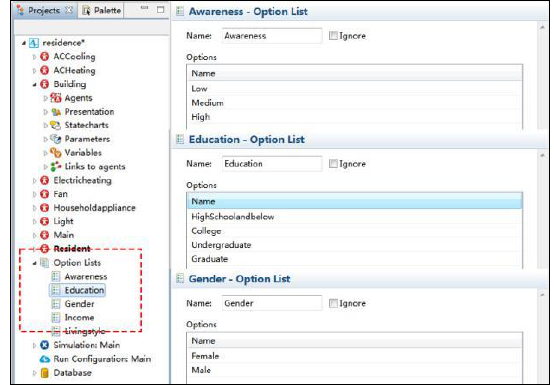
Figure 5. Personal characteristic options.